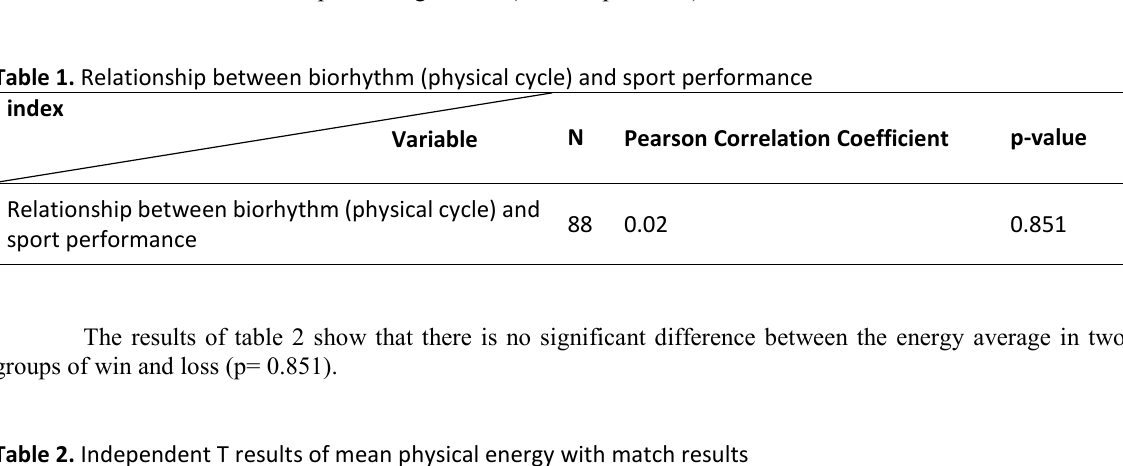
Table 2. Independent T results of mean physical energy with match results cycle